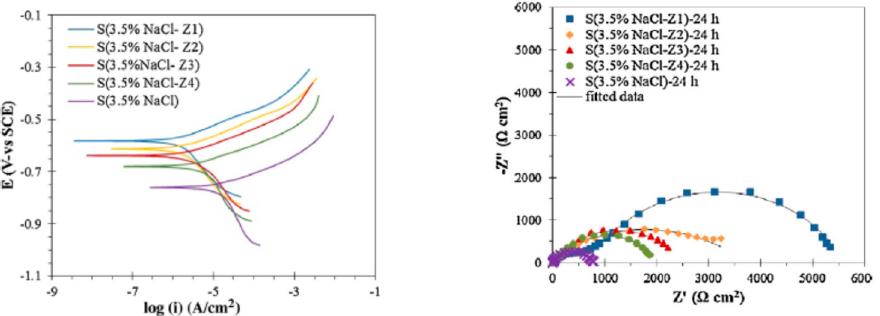
Figure 10. The polarization curves and AC impedance spectra of stainless steel coated with inhibtor doped zeolites after one-day immersion in 3.5% NaCl solutions [98].